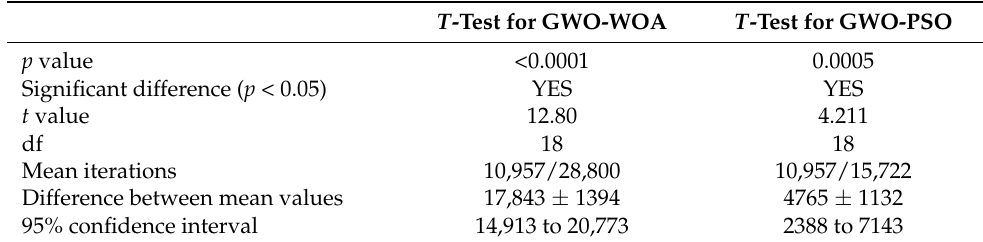
Table 11. Two-sample t-test results for used algorithms based on iterations. T -Test for GWO-WOA T -Test for GWO-PSO <0.0001